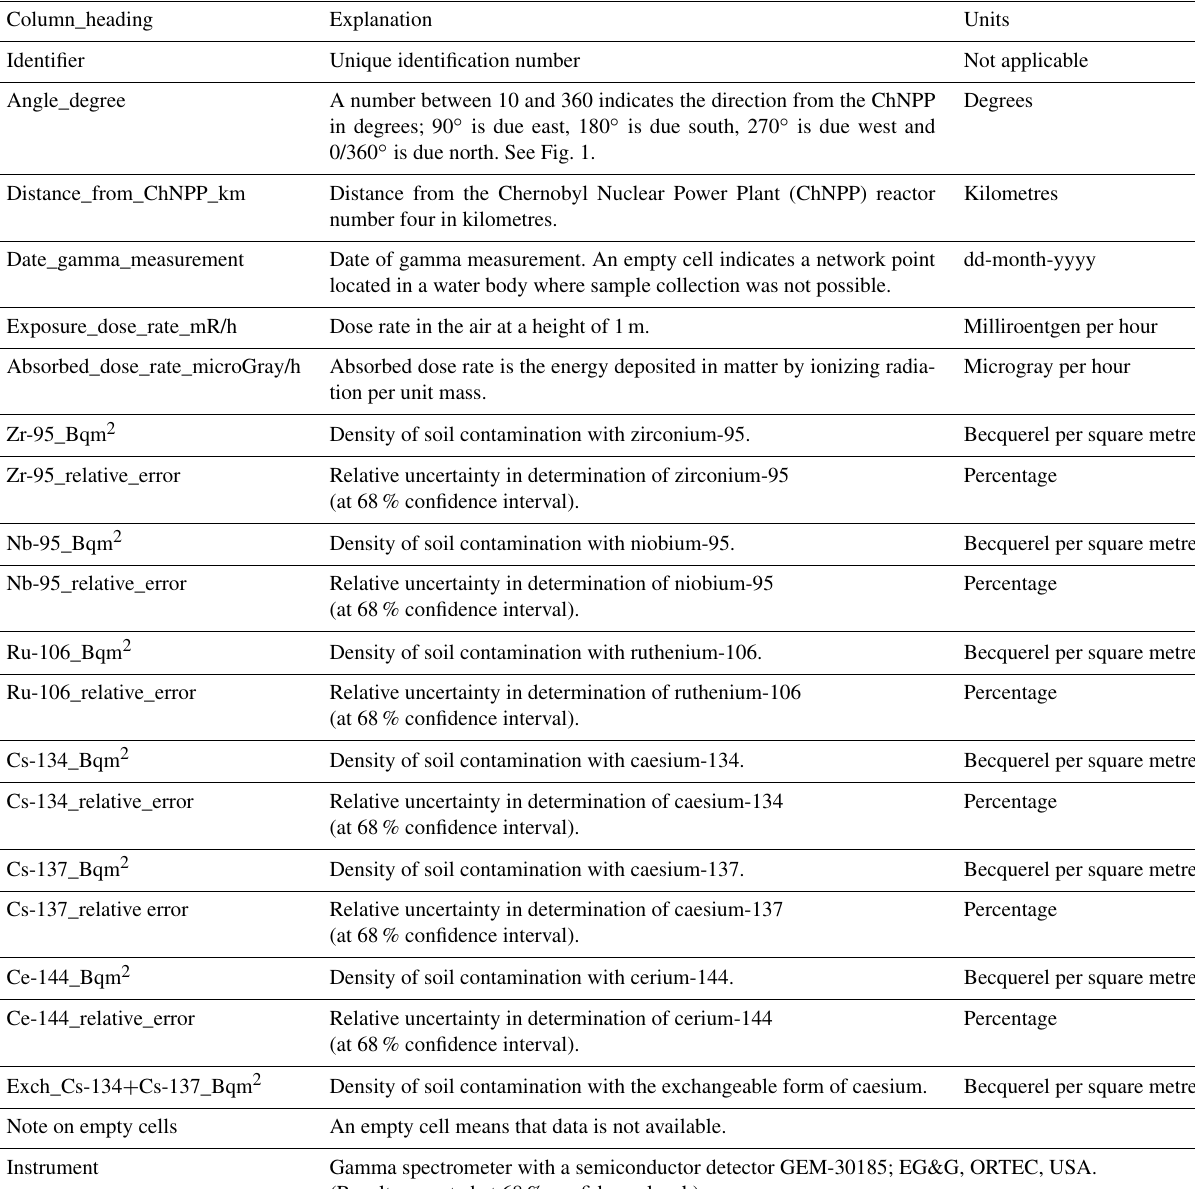
Table A1. A detailed explanation of the column headings and units (where applicable) which accompany the data (Kashparov et al., 2019).